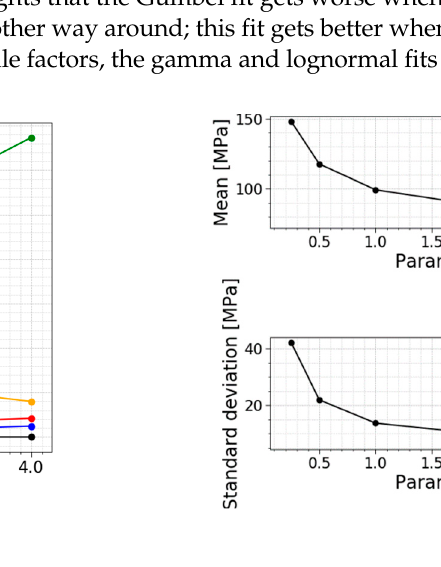
Figure 16. ( a ) AIC values and ( b ) the mean and st.dev. of the normal stress at failure for a varying scale factor. Table 4. Data for a varying scale factor.